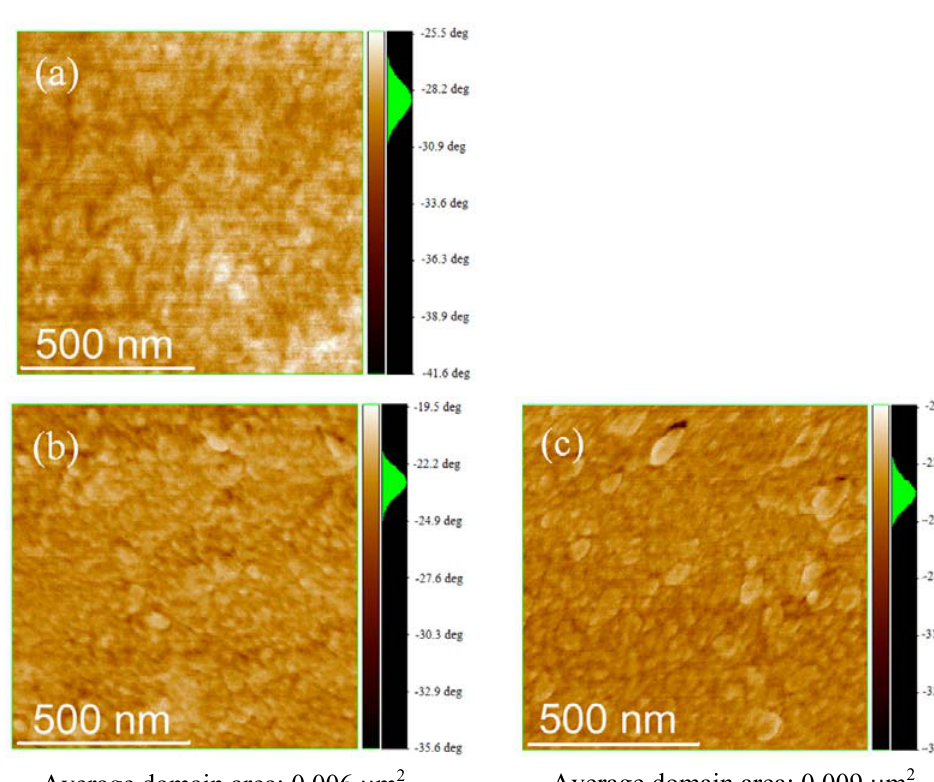
Figure 8. AFM phase images of the solar cells with PCBM:P(3HT- b